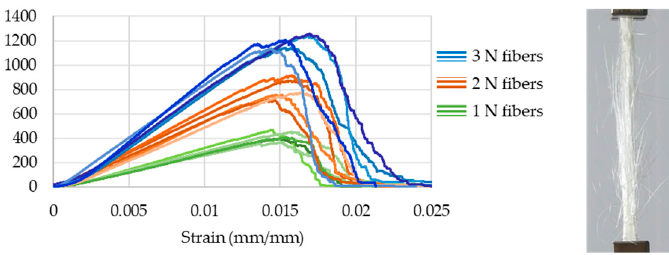
Figure 5. Superposition of all fiber tensile test results ( left ) with set amount (green), double amount (orange) and triple amount (blue) of fibers and the experiment itself ( right ).